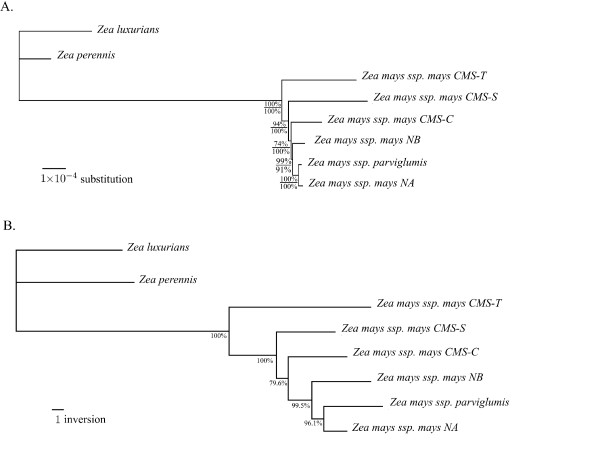
Phylogenetic trees for maize and teosinte mitogenomes. (A) Backbone DNA sequence phylogenetic tree. Phylogenetic tree was constructed using BIONJ and TREE-PUZZLE. The tree was rooted using Zea perennis and Zea luxurians. Branch lengths are proportional to substitution rates. Bootstrap values (upper values for distance and lower values for likelihood) are reported. (B) Structure sequence phylogenetic tree. Phylogenetic tree was constructed using BIONJ from the number of inversion distances obtained with GRIMM. The tree was rooted using Zea perennis and Zea luxurians. Branch lengths are proportional to the numbers of inversions. Jackknife values are reported.